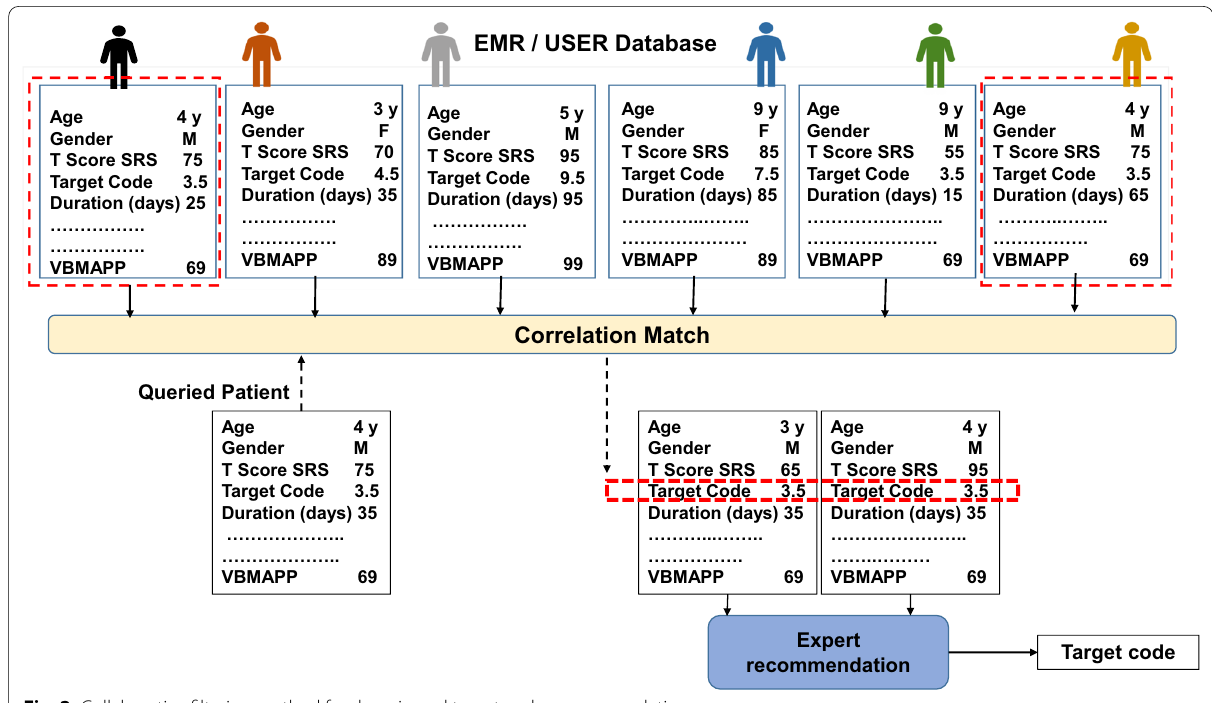
Fig. 2 Collaborative filtering method for domain and target code